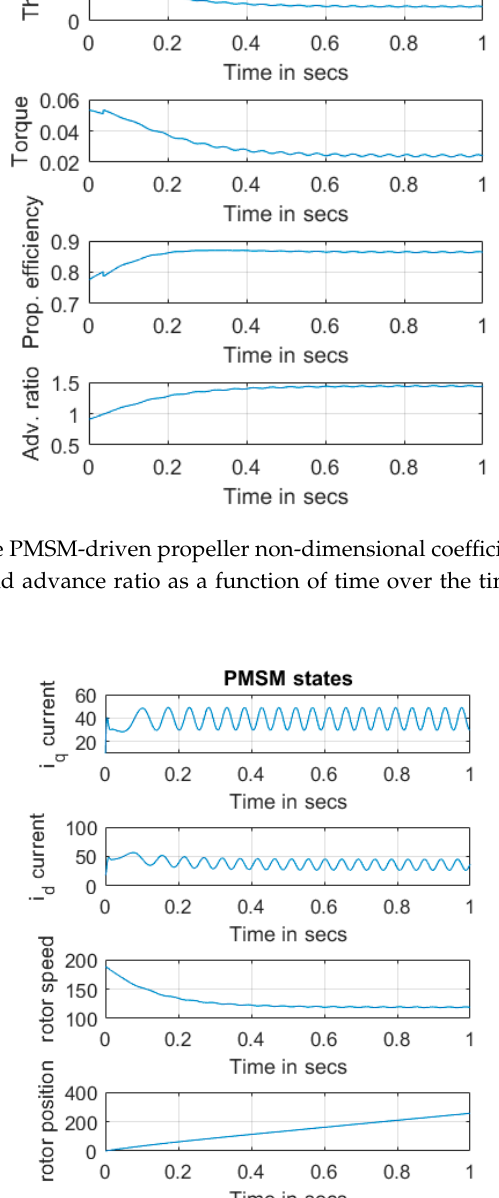
Figure 4. Variation of the high-temperature superconductor (HTS) PMSM characteristics as a function of time over the timeframe of 1 s at the superconducting temperature.